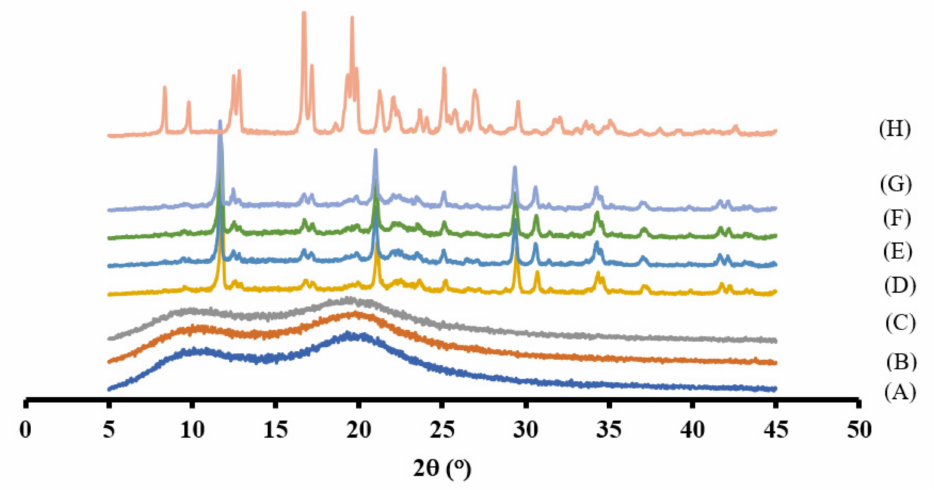
Figure 4. PXRD patterns of H-K4M ( A ), H-K15M ( B ) H-K100M ( C ), Tab-K4M ( D ), Tab-K15M ( E ), Tab-K100M ( F ) Tab-Mixed ( G ), and PNL ( H